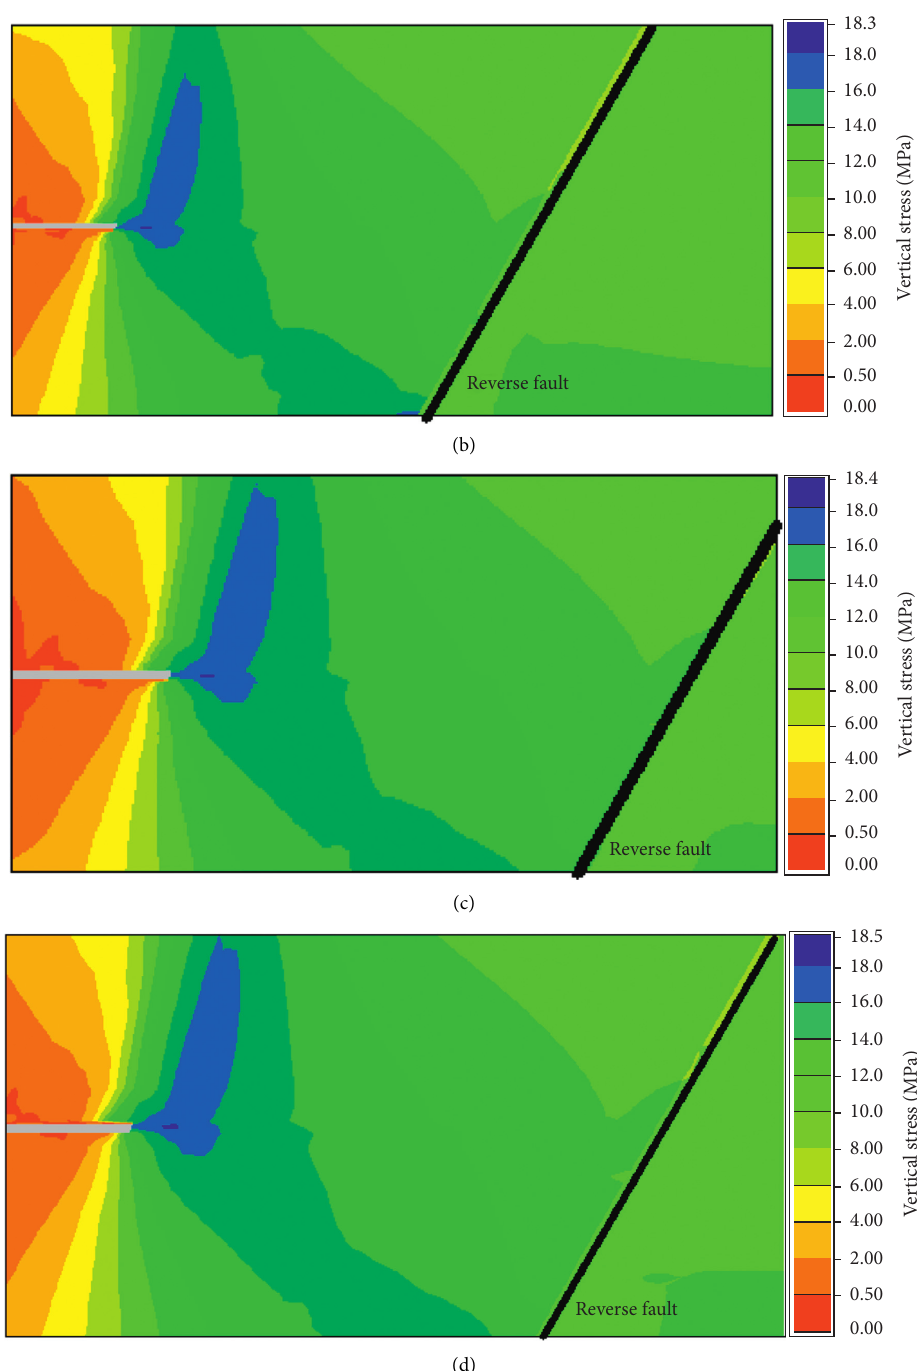
Figure 12: Stress distribution when the distance between working face and reverse fault is 70m with different fault throw. (a) The throw of reverse fault is 4m. (b) The throw of reverse fault is 10m. (c) The throw of reverse fault is 15m. (d) The throw of reverse fault is